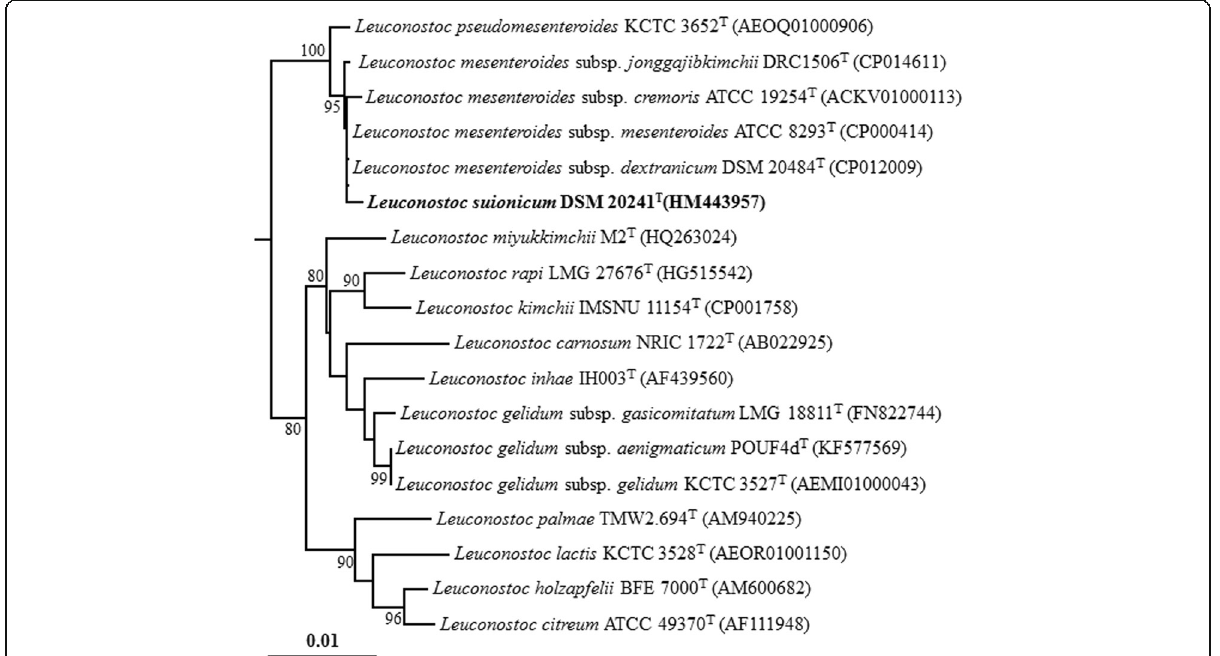
Fig. 2 Neighbor-joining tree based on the 16S rRNA gene sequences showing the phylogenetic relationships between Leuconostoc suionicum DSM 20241 T ( highlighted in bold ) and closely related Leuconostoc species. The sequences were aligned using the fast secondary-structure aware Infernal aligner available from the Ribosomal Database Project [28] and the tree was constructed based on the neighbor-joining algorithm using PHYLIP software (ver. 3.68) [29]. Bootstrap values of over 70% are shown on the nodes as percentages of 1000 replicates. Weissella viridescens 1536 T (AB023236) was used as an outgroup (not shown). Bar indicates 0.01 changes